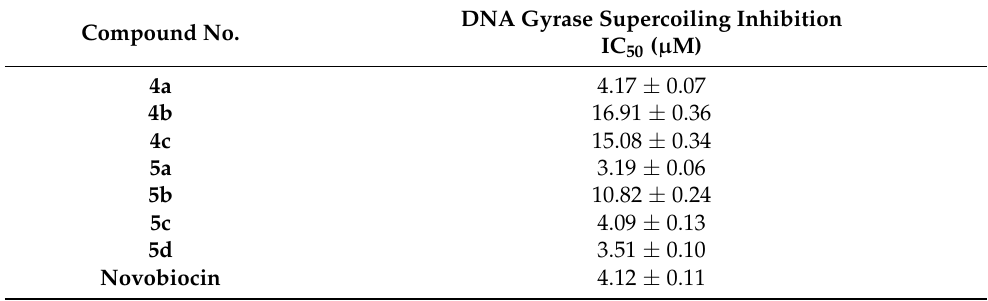
Table 3. In vitro enzymatic inhibitory activity against E coli DNA gyrase. Compound